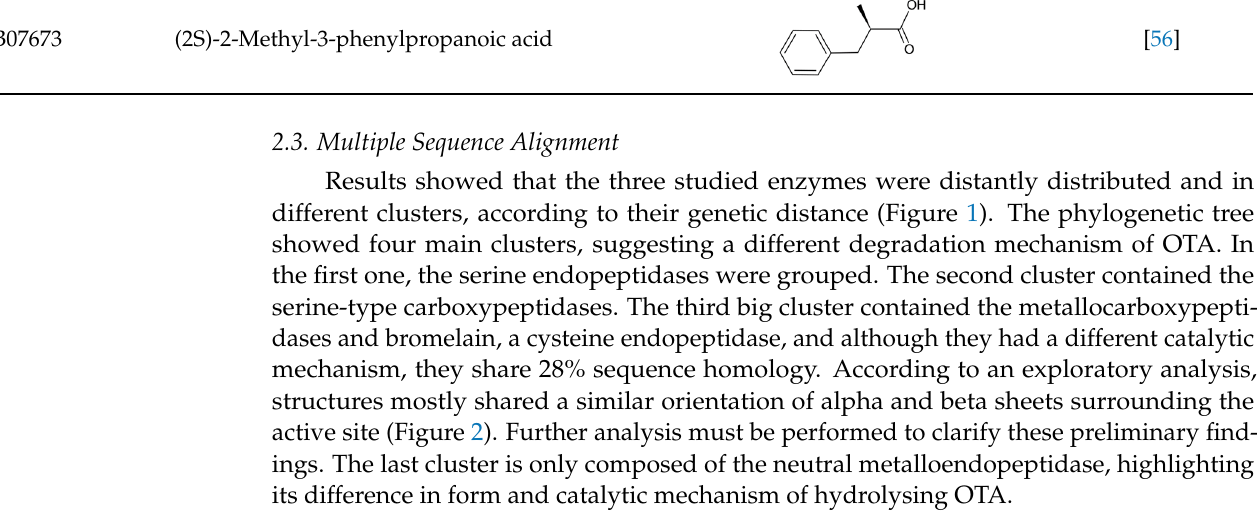
Figure 2. 3D Structure alignment of Bromelain and Carboxipeptidase A. The exploratory analysis showed that Bromelain and Carboxypeptidase A mostly share a similar structural conformation surrounding the binding pocket, despite its 28% sequence homology and different catalytic